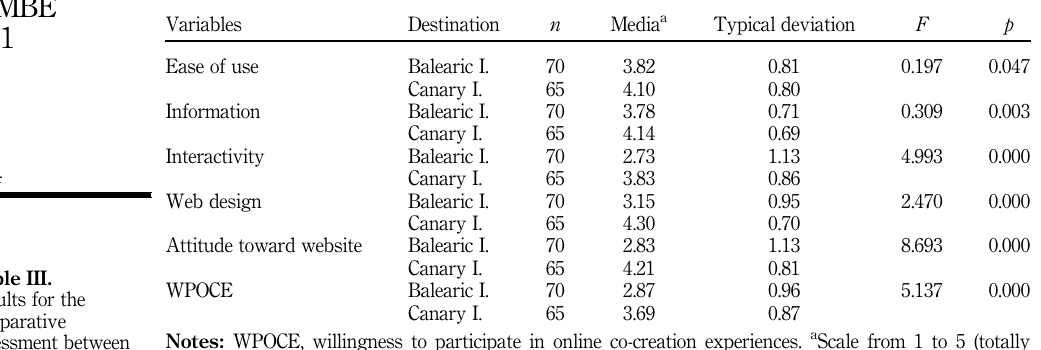
Table III. Results for the comparative assessment between